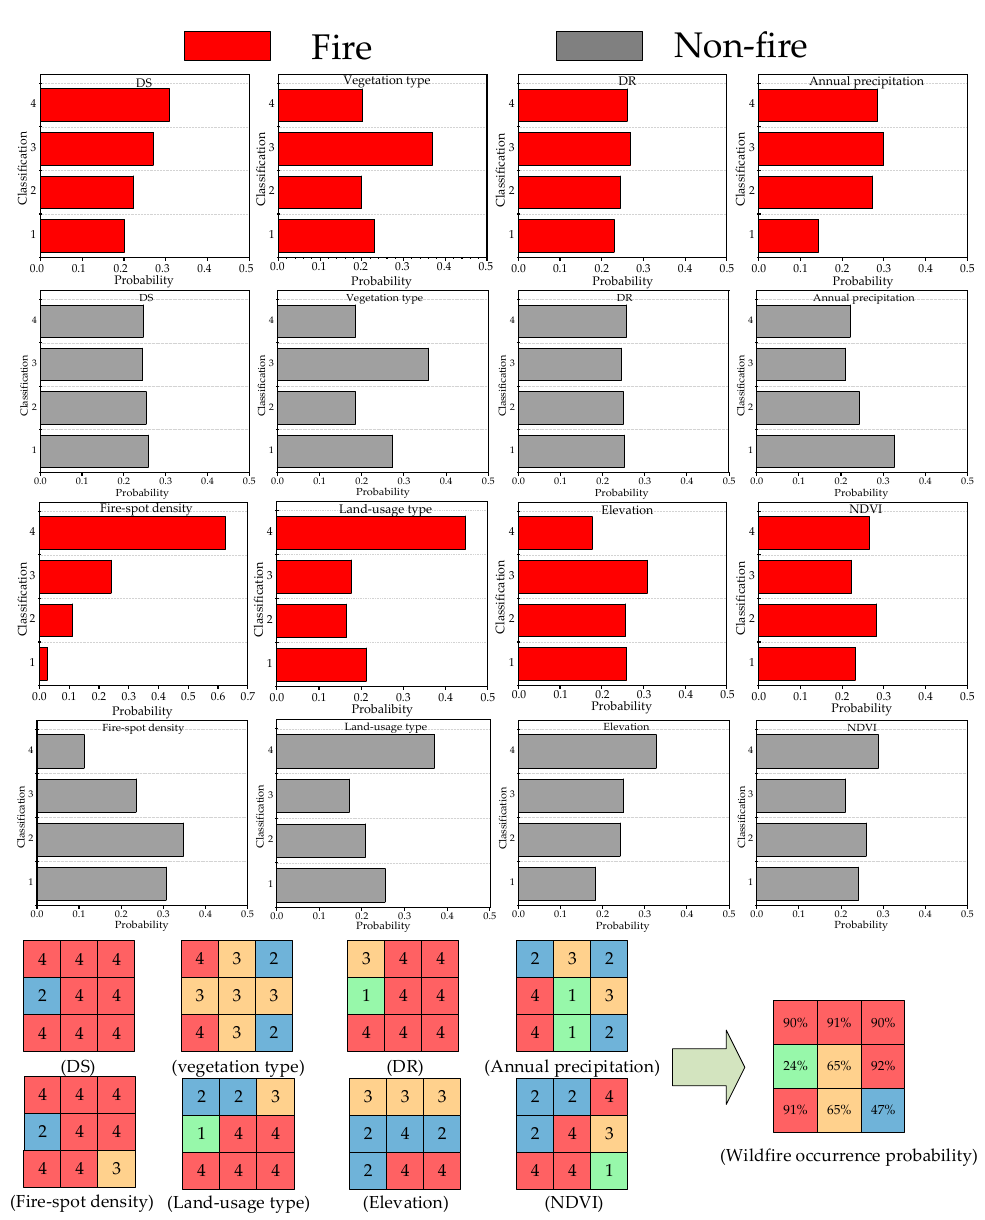
Figure 5. Conditional probability distribution of wildfire-related factors and an example of probability inference. The NBN-based wildfire risk distribution of Guangxi province is mapped by using the ArcGIS software (Figure 6a). For comparison, another wildfire risk distribution map is drawn according to the DG of State Grid Corporation of China (Figure 6b) [21]. In addition, a total of 527 fire events, which were monitored by remoting satellite during the first season in 2020, allocate on the maps.